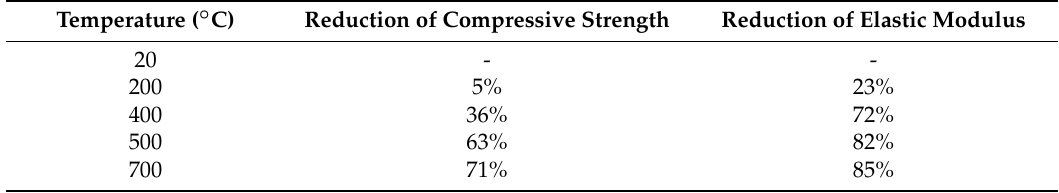
Table 4. Reduction of compressive strength and elastic modulus of TRC after exposure to high temperatures.